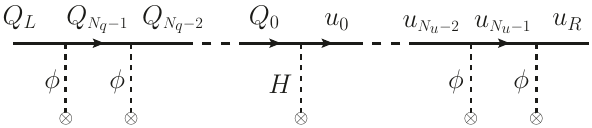
Figure 4 . An example of a Feynman diagram that generates the hierarchical quark masses in FN